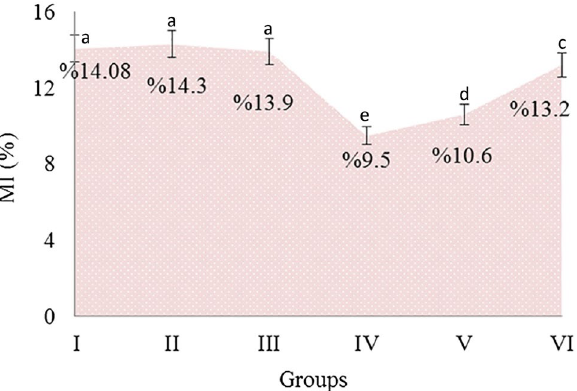
Figure 9. The effects of AFM 1 and t-rsv applications on MI. MI was calculated by analyzing 1000 cells per animal (for a total of 6000 cells per group). Different letters (a–h) indicated averages p < 0.05 are